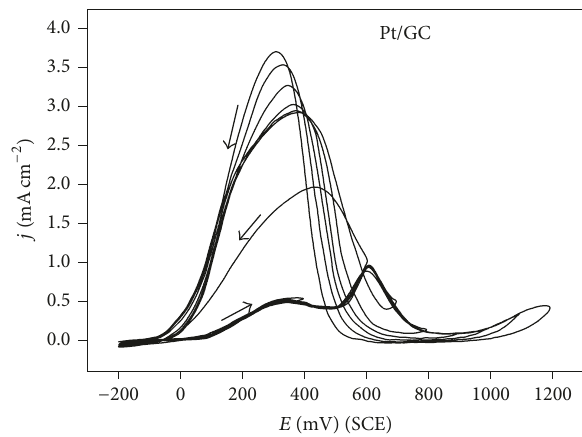
Figure 4: CVs for oxidation of 0.125 M HCOOH in 0.1M H 2 SO 4 on Pt/GC electrode at 50mVs – 1 and 𝜛 = 1500 rpm for the successive increases of the forward potential scan